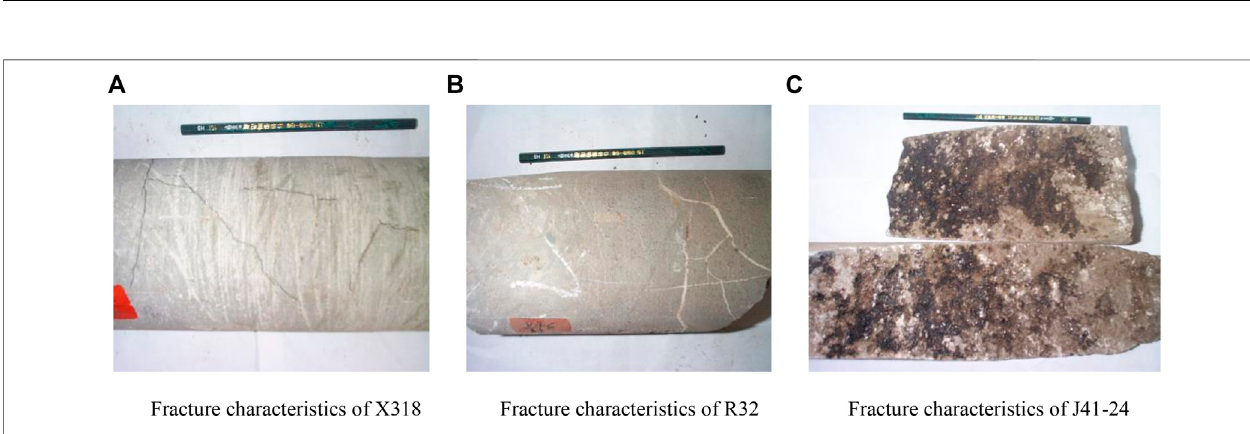
FIGURE 2 | Observation of typical fracture characteristics in the target reservoir core. (A) Fracture characteristics of X318. (B) Fracture characteristics of R32. (C) Fracture characteristics of J41-24.